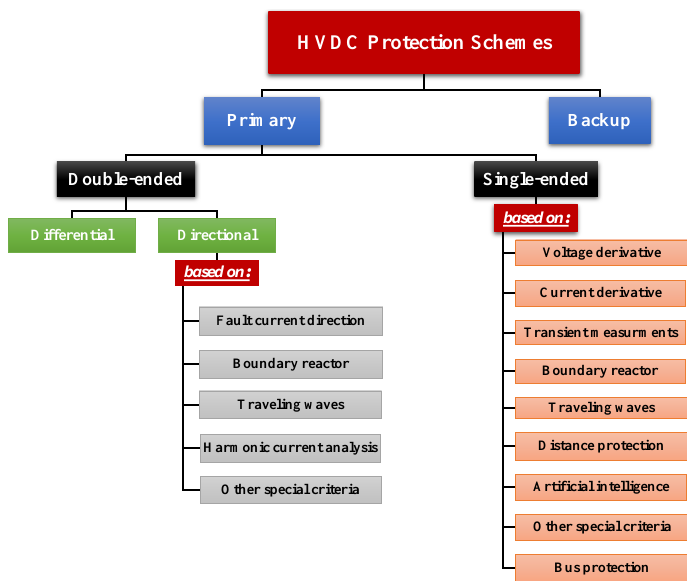
Figure 12. Classification of HVDC grid protection